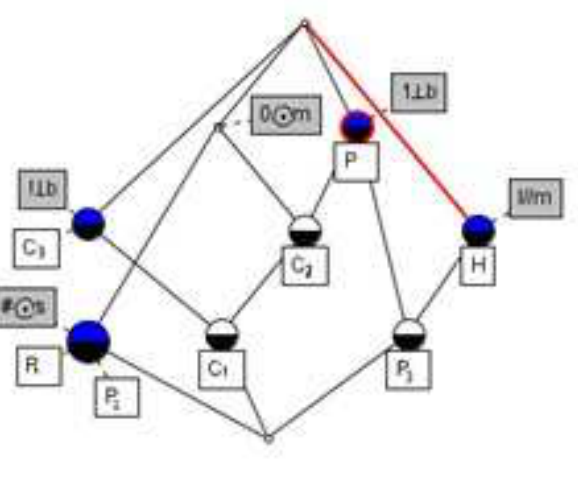
Figure 8. The concept lattice of Table